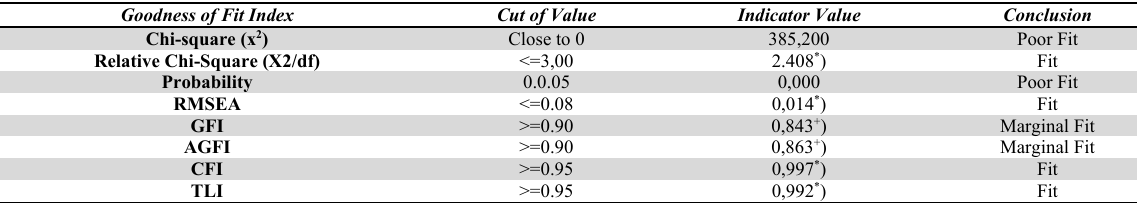
Evaluation of Goodness of Fit Goodness of Fit Index Cut of Value Indicator Value Conclusion Chi-square (x 2 )